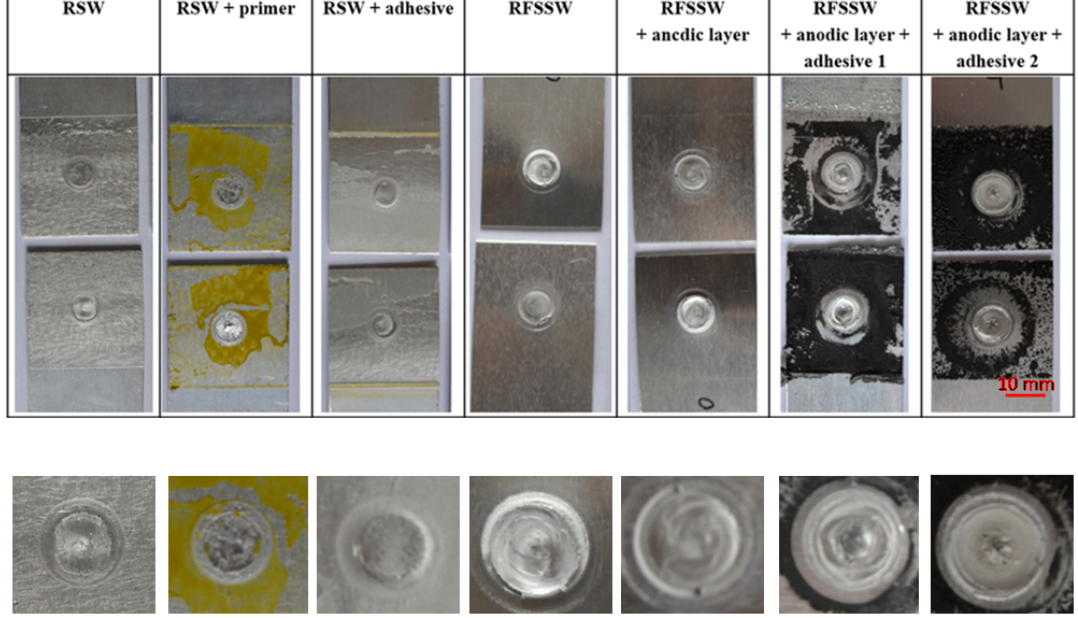
Figure 13. The surface morphologies of RSW and RFSSW joints after breaking .